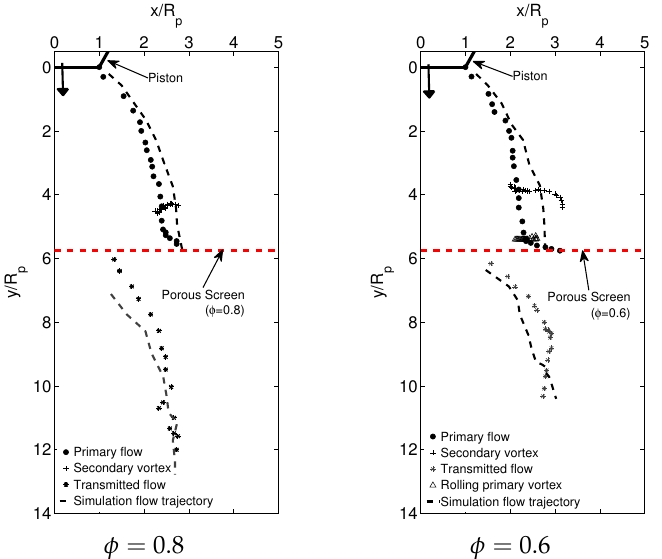
Figure 6. Trajectory of vortex ring interaction with porous screen: simulation in the current study (dashed lines) vs. experimental results from An et al. [14] at Re = 1800 and t = 1.12 s.